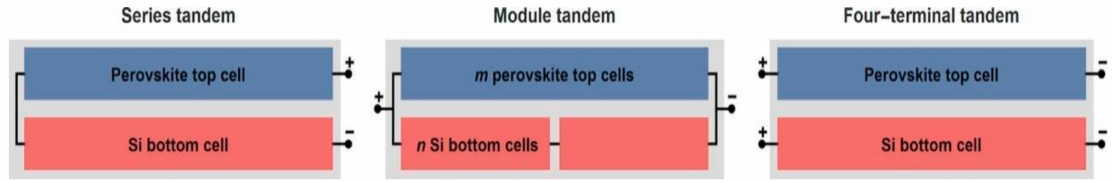
Figure 3. Si-Perovskite Tandem configurations, characterised by the number and connection of Perovskite and Silicon solar cell. Figure Taken from Futscher et al. [100].